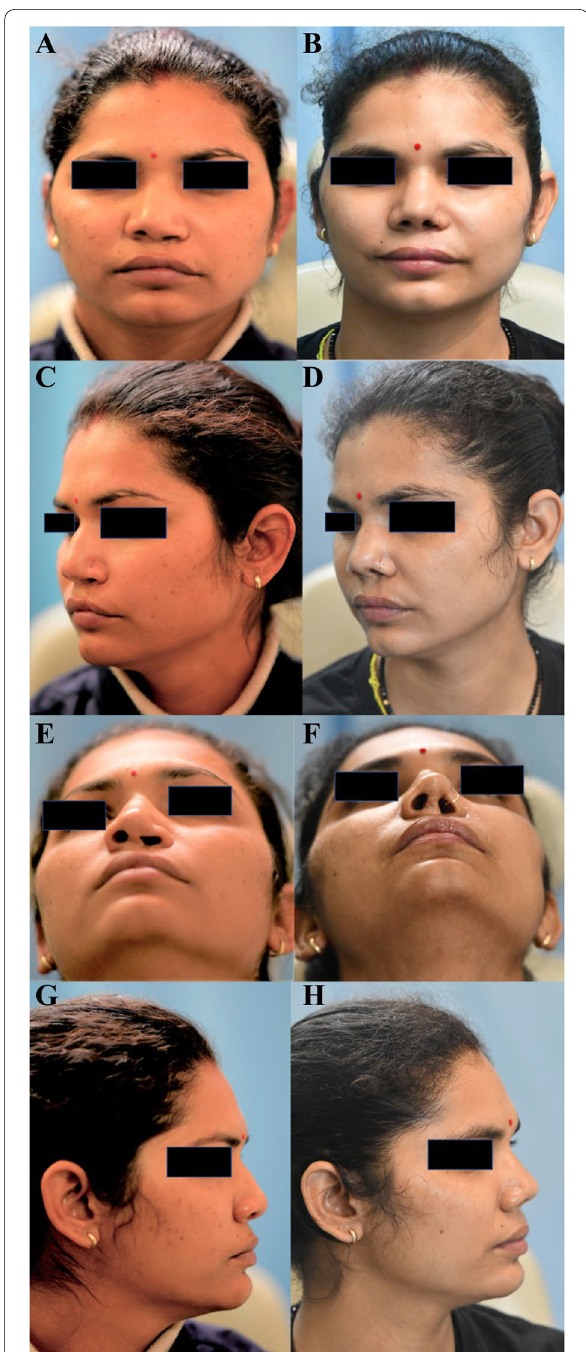
Fig. 8 Comparative pre- and post-operative pictures at 3 years follow-up. A Preoperative frontal view. B Postoperative frontal view. C Pre-operative Right oblique view. D Post operative right oblique view. E Pre-operative basal view. D Postoperative basal view. F Pre-operative left lateral view. G Post operative left lateral